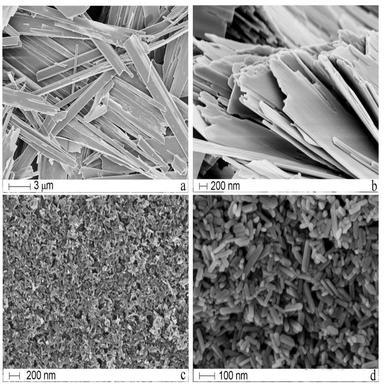
SEM images of HAp (a–b) and Ge-HAp (c–d). Scale bars are 3 μm (a), 200 nm (b, c), and 100 nm (d).